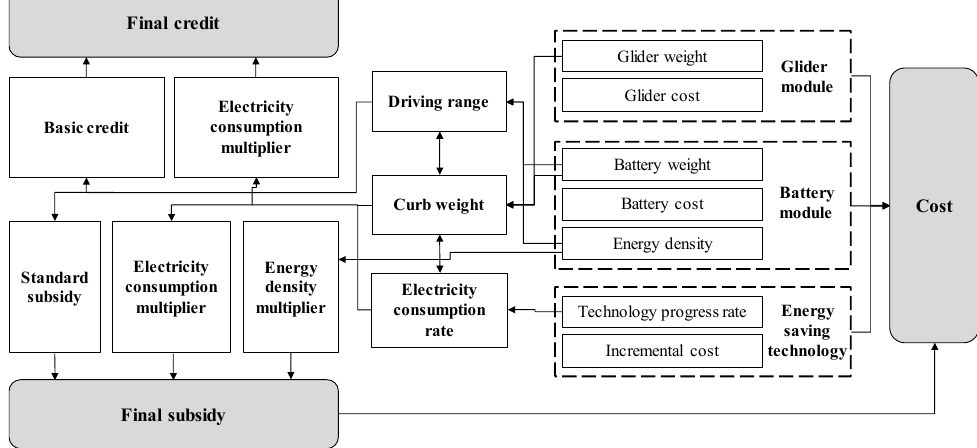
Figure 2. The accounting framework of the bottom-up model.